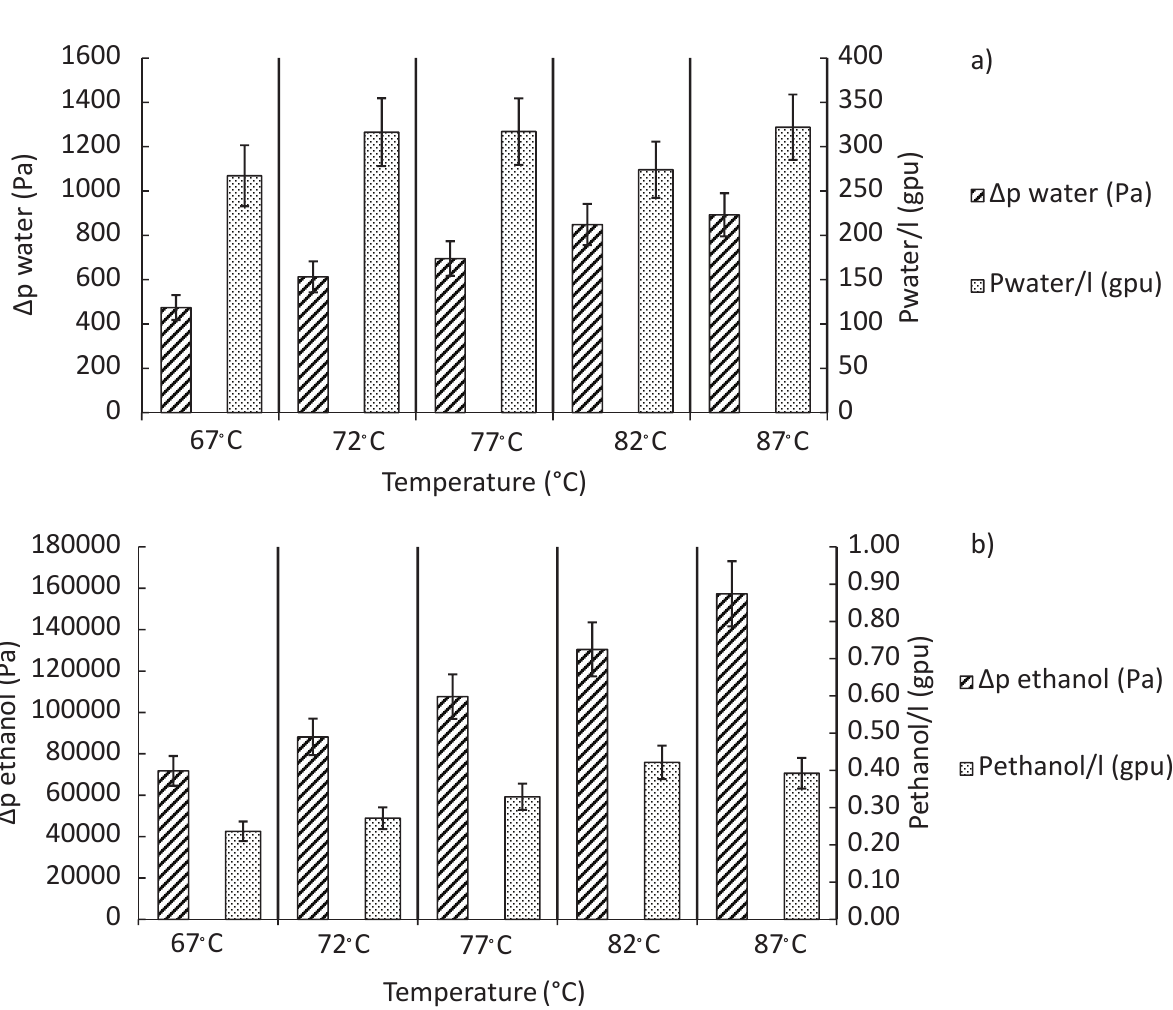
Figure 9: Influence of the temperature on the pressure gradient and the permeance for ethanol-water solution with 0.33 %wt of